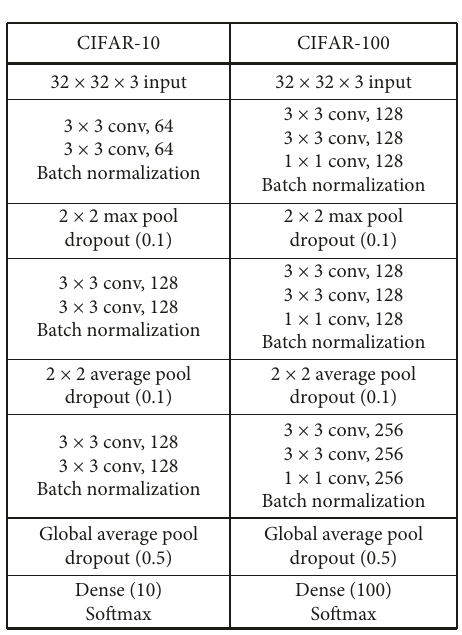
Figure 5: The structure of two specially designed deep CNNs.